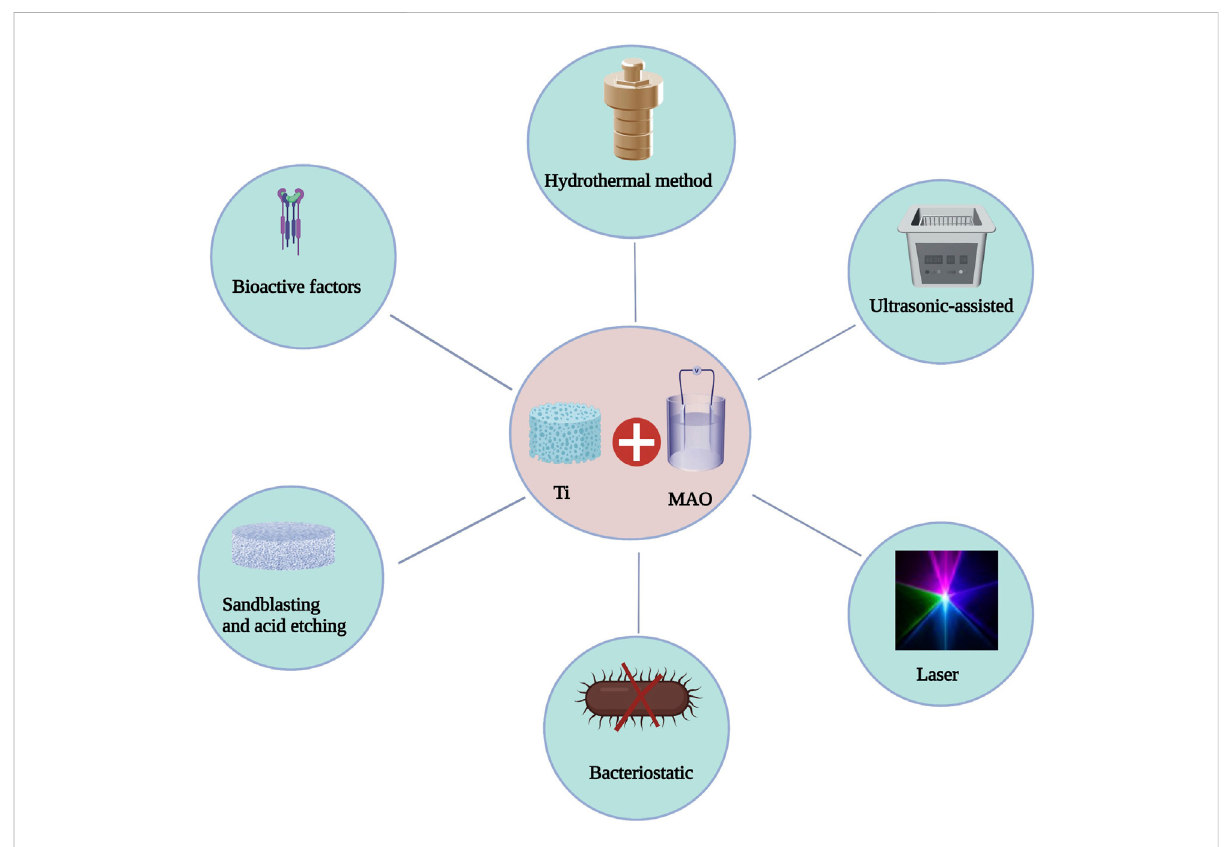
FIGURE 3 Combined application of MAO and other treatment